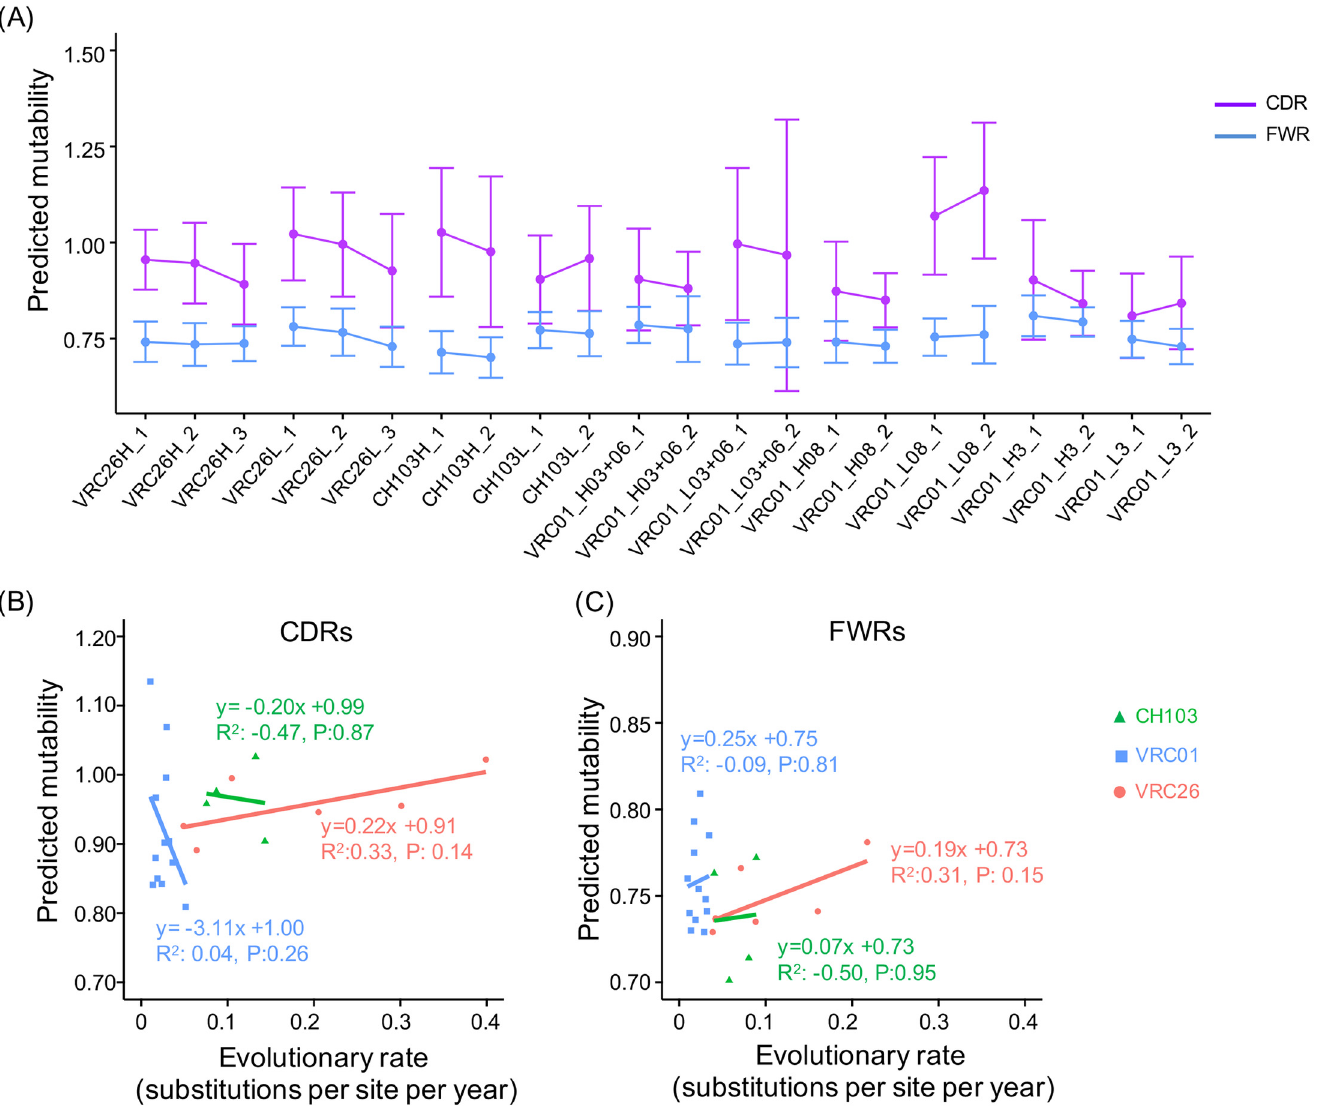
Fig 9. The longitudinal changes of the predicted mutability correlate weakly with evolutionary rate decrease. (A) Predicted mutability for the stages of the three lineages. (B) The correlations between predicted mutability and evolutionary rate of CDRs were estimated using linear regression. No statistically significant correlation between the selection strength and evolutionary rate was observed. (C) The linear correlations between predicted mutability and evolutionary rate of FWRs. No significant correlation was observed for the three lineages.